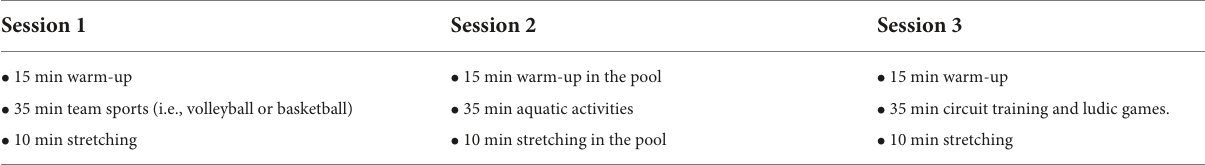
TABLE 1 Training program for active group before and during